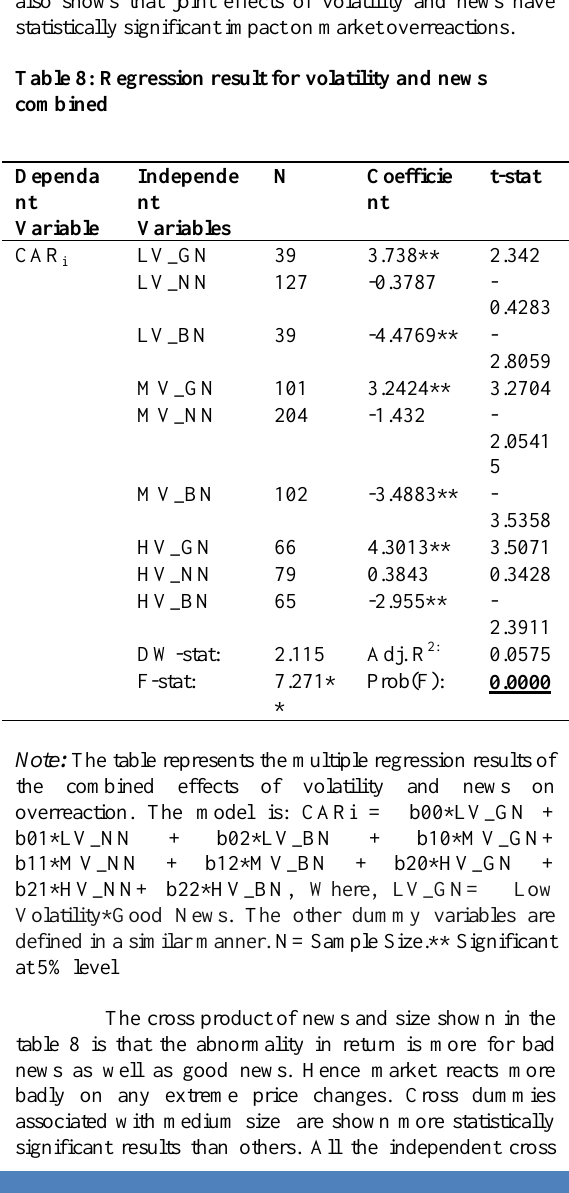
Note: The table represents the multiple regression results of the combined effects of volatility and size on overreaction.